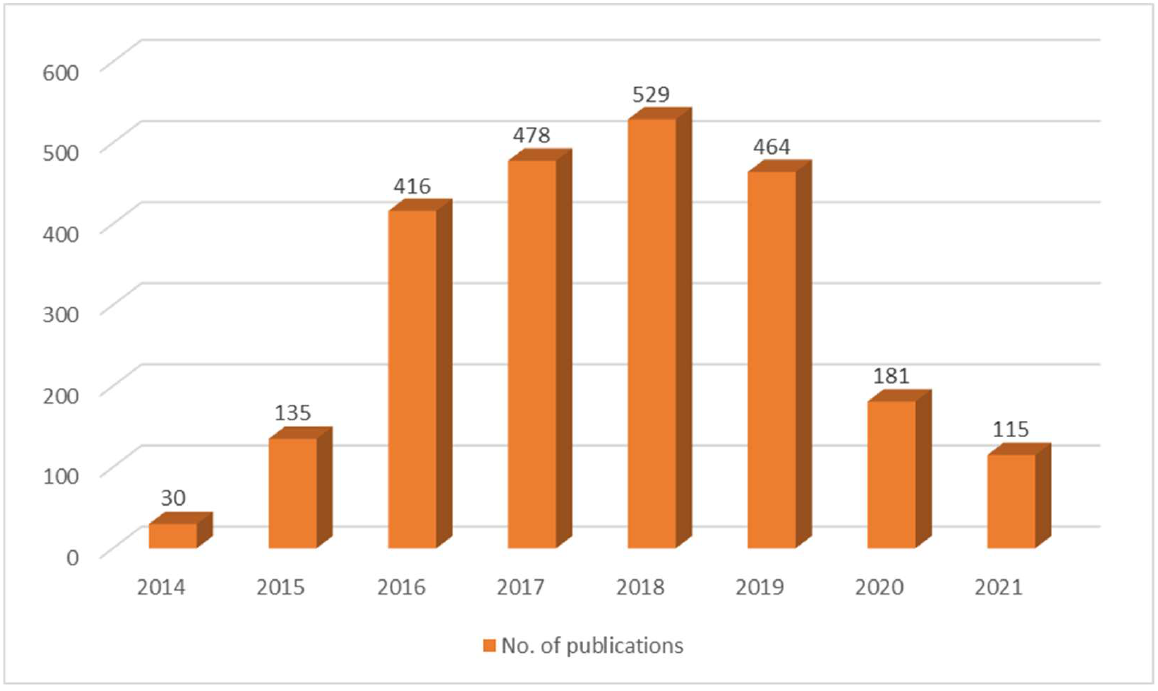
Figure 3. Number of publications per year.